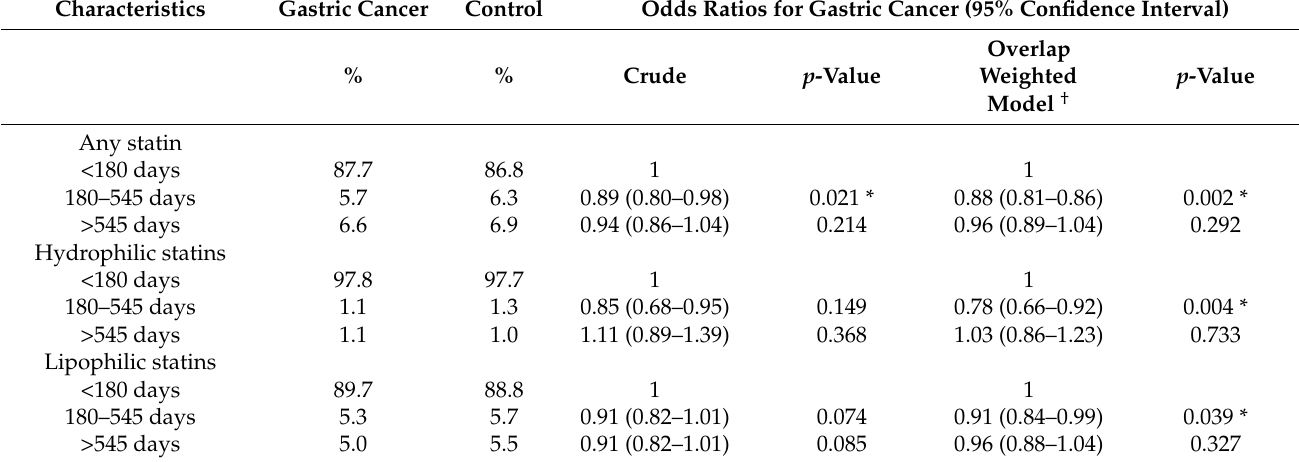
Table 2. Crude and overlap propensity score weighted odds ratios of dates of statin prescription for gastric cancer according to statin